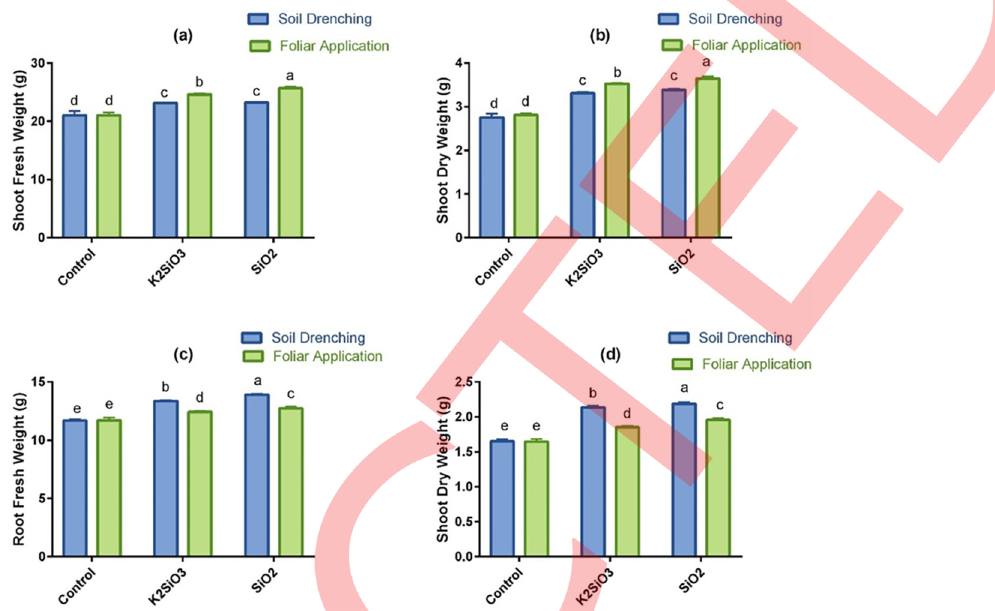
Fig 4. Effect of Si sources and Si application methods on (a) shoot fresh weight (g), (b) shoot dry weight (g), (c) root fresh weight (g), and (d) root dry weight (g) of maize. Bars with different lower-case letters are significantly different; LSD test at p � 0.05. Vertical bars indicate SD.